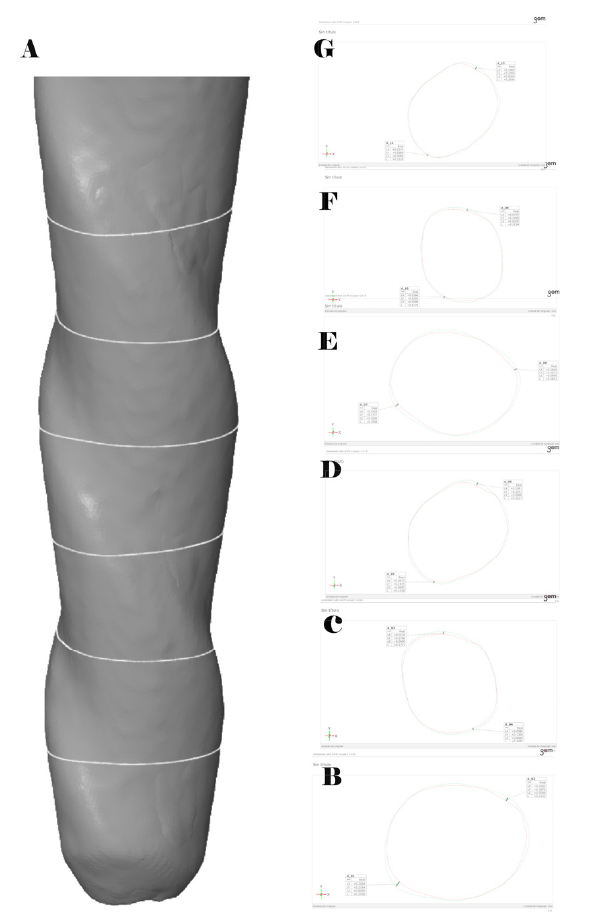
Figure 3. ( A ) Three-dimensional reconstruction of the aligned preoperative and postoperative digital files of the CM-wire NiTi alloy endodontic reciprocating files and cross sections at ( B ) 1 mm, ( C ) 2 mm, ( D ) 3 mm, ( E ) 4 mm, ( F ) 5 mm, and ( G ) 6 mm from the tip of the files.